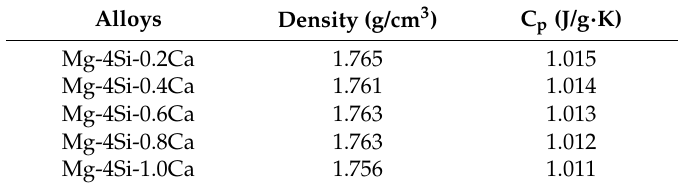
Table 2. Room temperature density and calculation of specific heat capacity of Mg–4Si–yCa alloys.